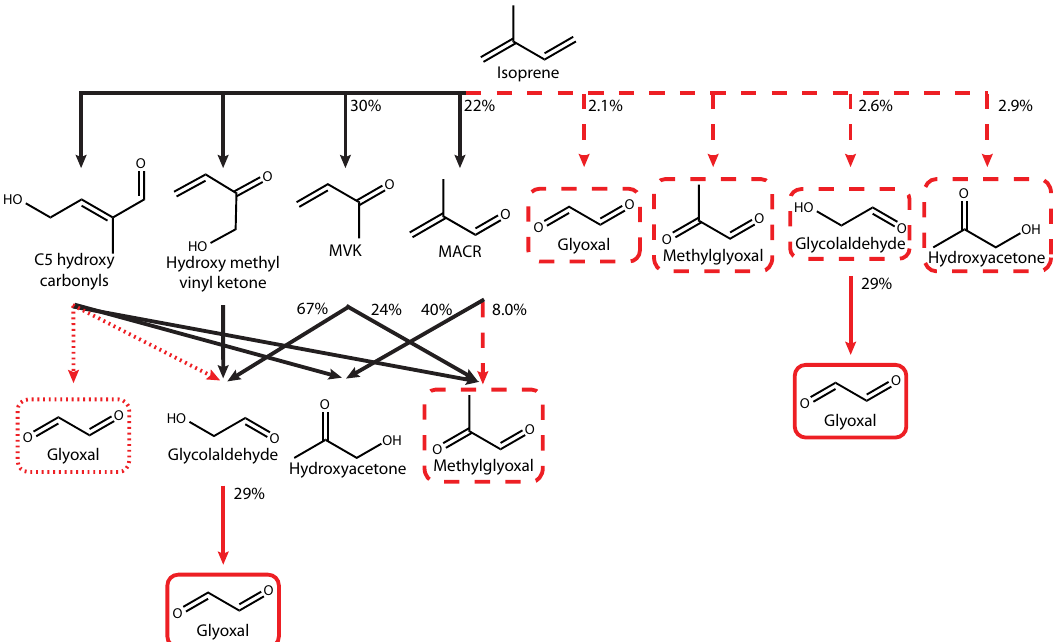
Fig. 6. Isoprene oxidation scheme. Dashed lines indicate first-generation formation pathways not included in the MCM. The dashed MACR to methylglyoxal line was not included in MCM v.3.1, but is included in MCM v.3.2 and was confirmed in this study. Dotted lines indicate the modifications to glyoxal production from C5 hydroxycarbonyls to 1/6 of the MCM v.3.2 yield in our modelling studies. The solid red line indicates a yield verified by measurements with this study and the study by Chan et al. (2009). Yields given are those found in this study. The C5 hydroxycarbonyl shown here is one of multiple isomers in the MCM, which refers to them as HC4CCHO (shown here) and